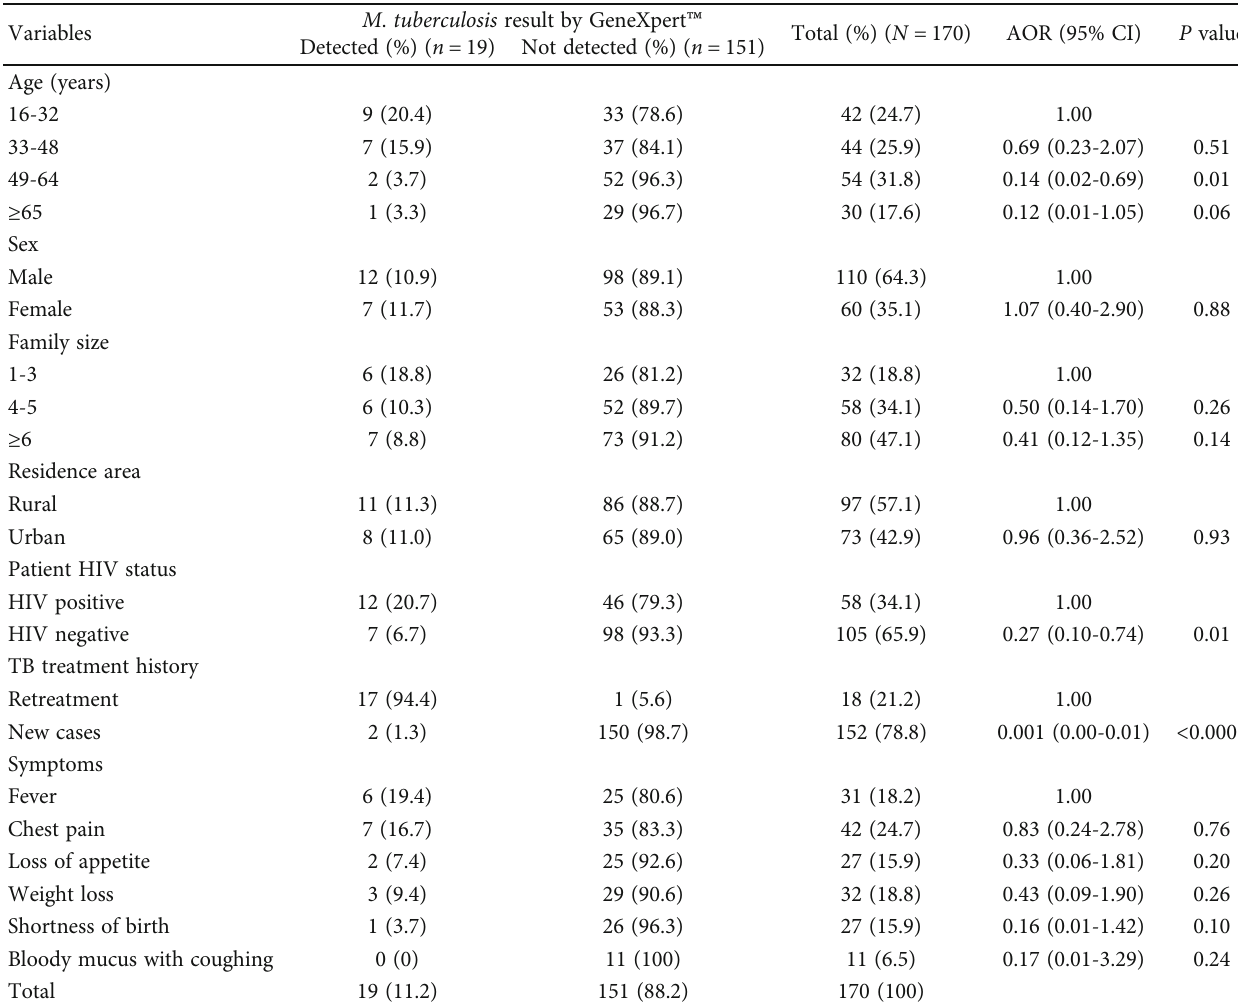
Table 2: Association of study participant characteristics to the prevalence of TB at Enat Hospital, Merhabete district, Central Ethiopia, 2020 ( N = 170